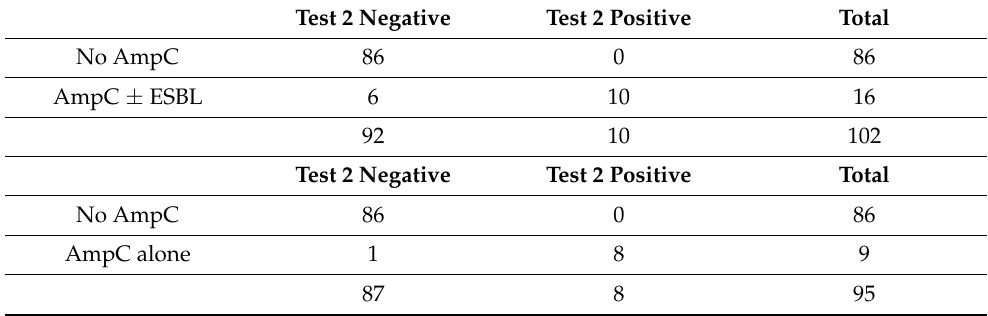
Table 7. Detection of isolates with AmpC using Test 2.